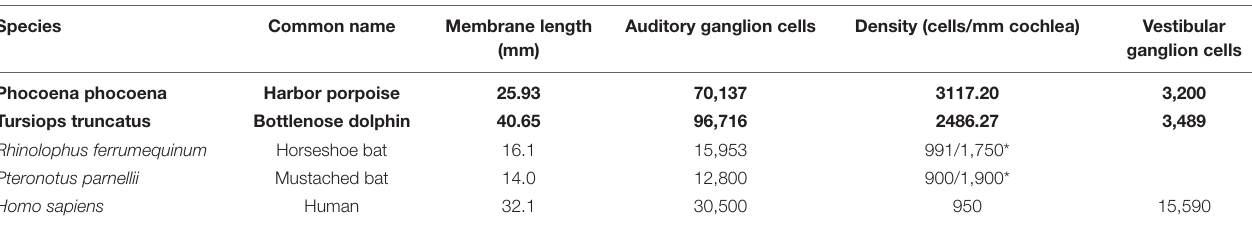
TABLE 2 | Auditory and vestibular nerve